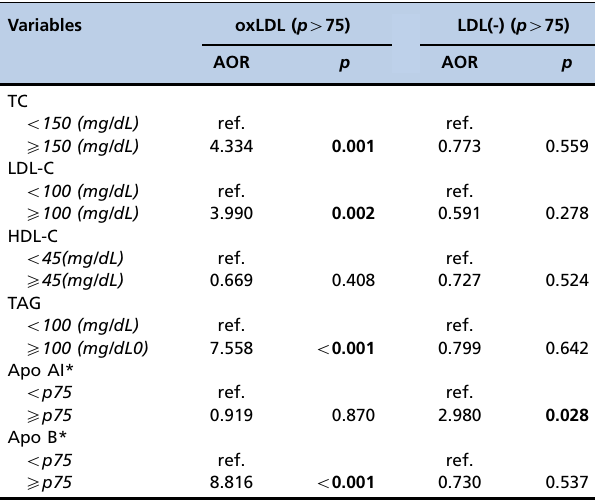
Table 3 - Multiple Logisitic Regression Models for impact of lipid profile in modified low-density lipoprotein: oxLDL and LDL(-). Variables